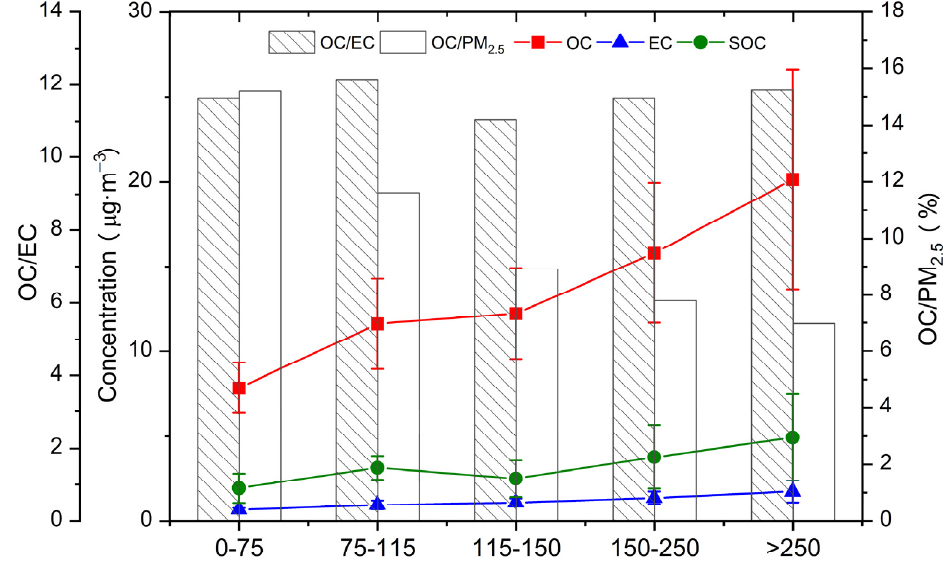
Figure 5. Concentrations of OC and EC, the values of OC/EC and OC/PM 2.5 in PM 2.5 during different air qualities in Shihezi.